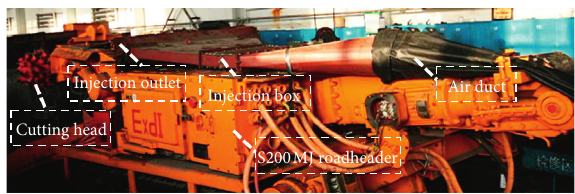
Figure 2: The location of the ACDRD on the roadheader.